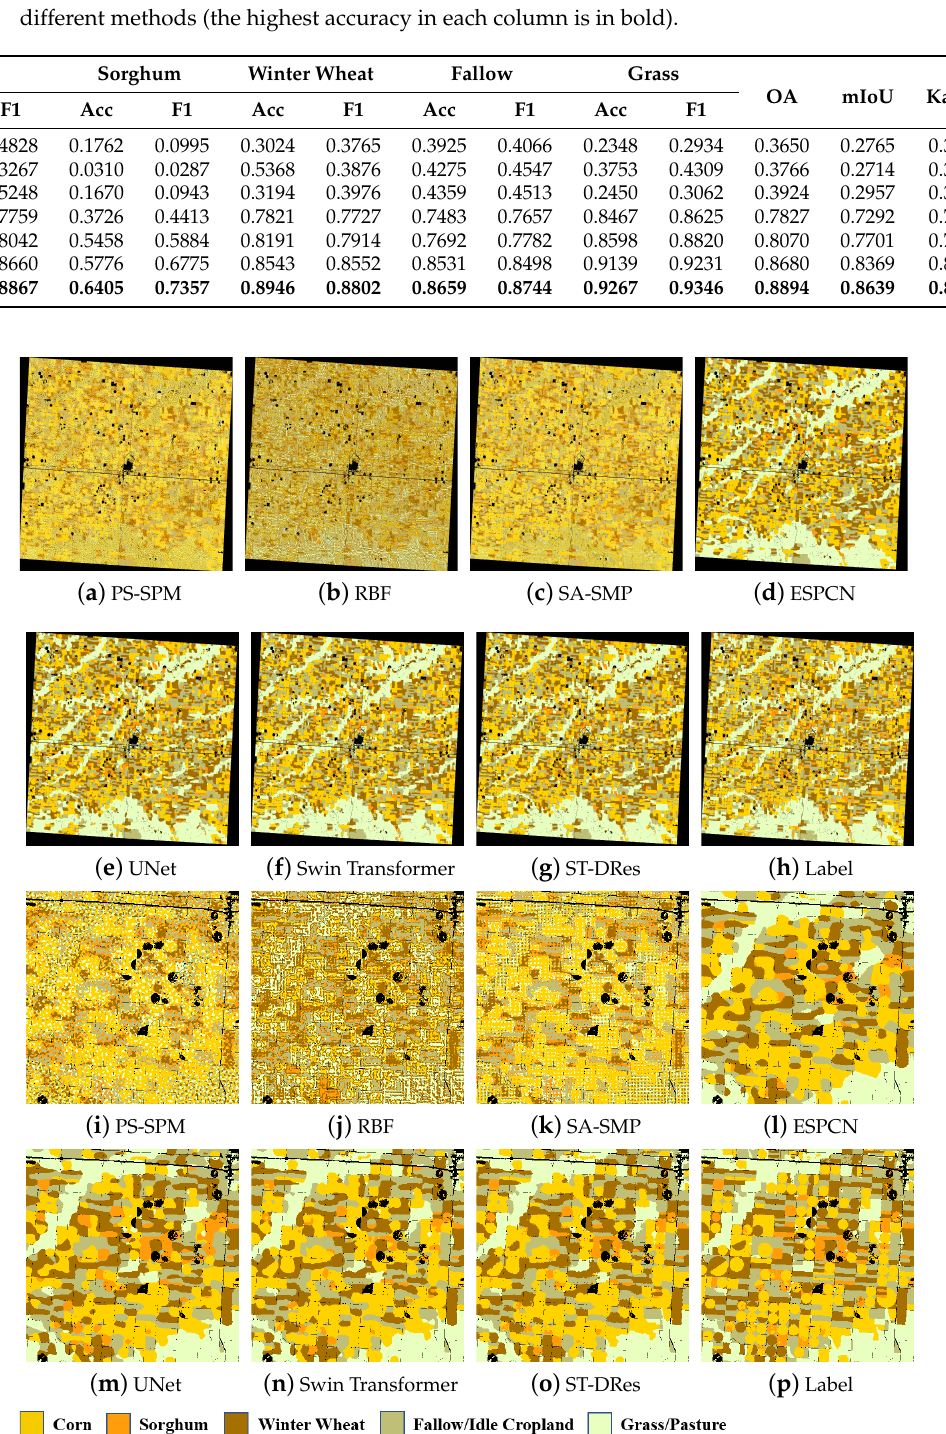
Table 2. The accuracy, F1 score of each class, OA, mIoU, and Kappa coefficients of the test sets of different methods (the highest accuracy in each column is in bold).